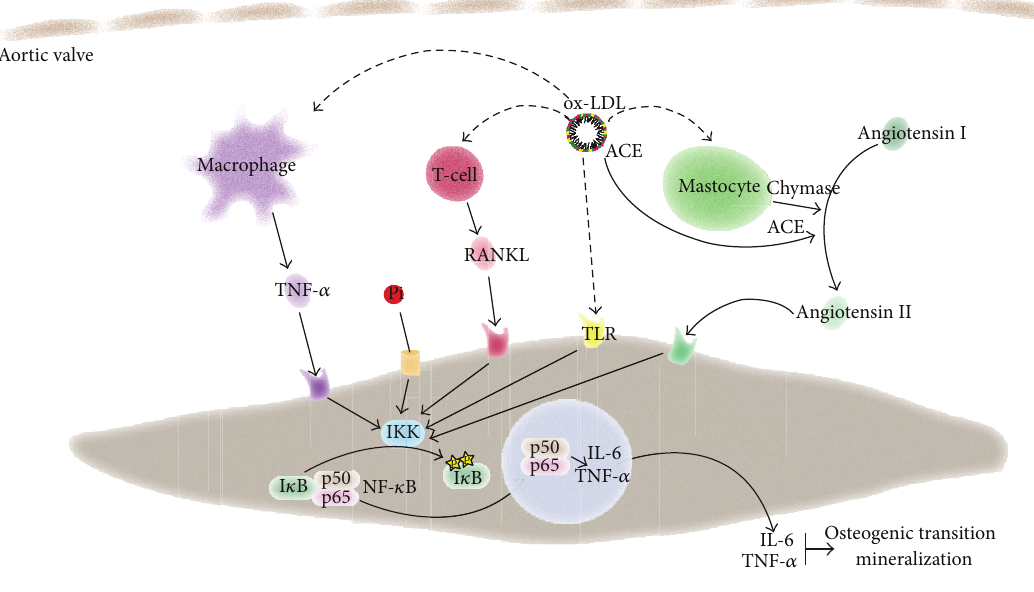
Figure 1: Scheme showing the interaction between inflammatory cells and valve interstitial cells (VICs) and its role during CAVD.